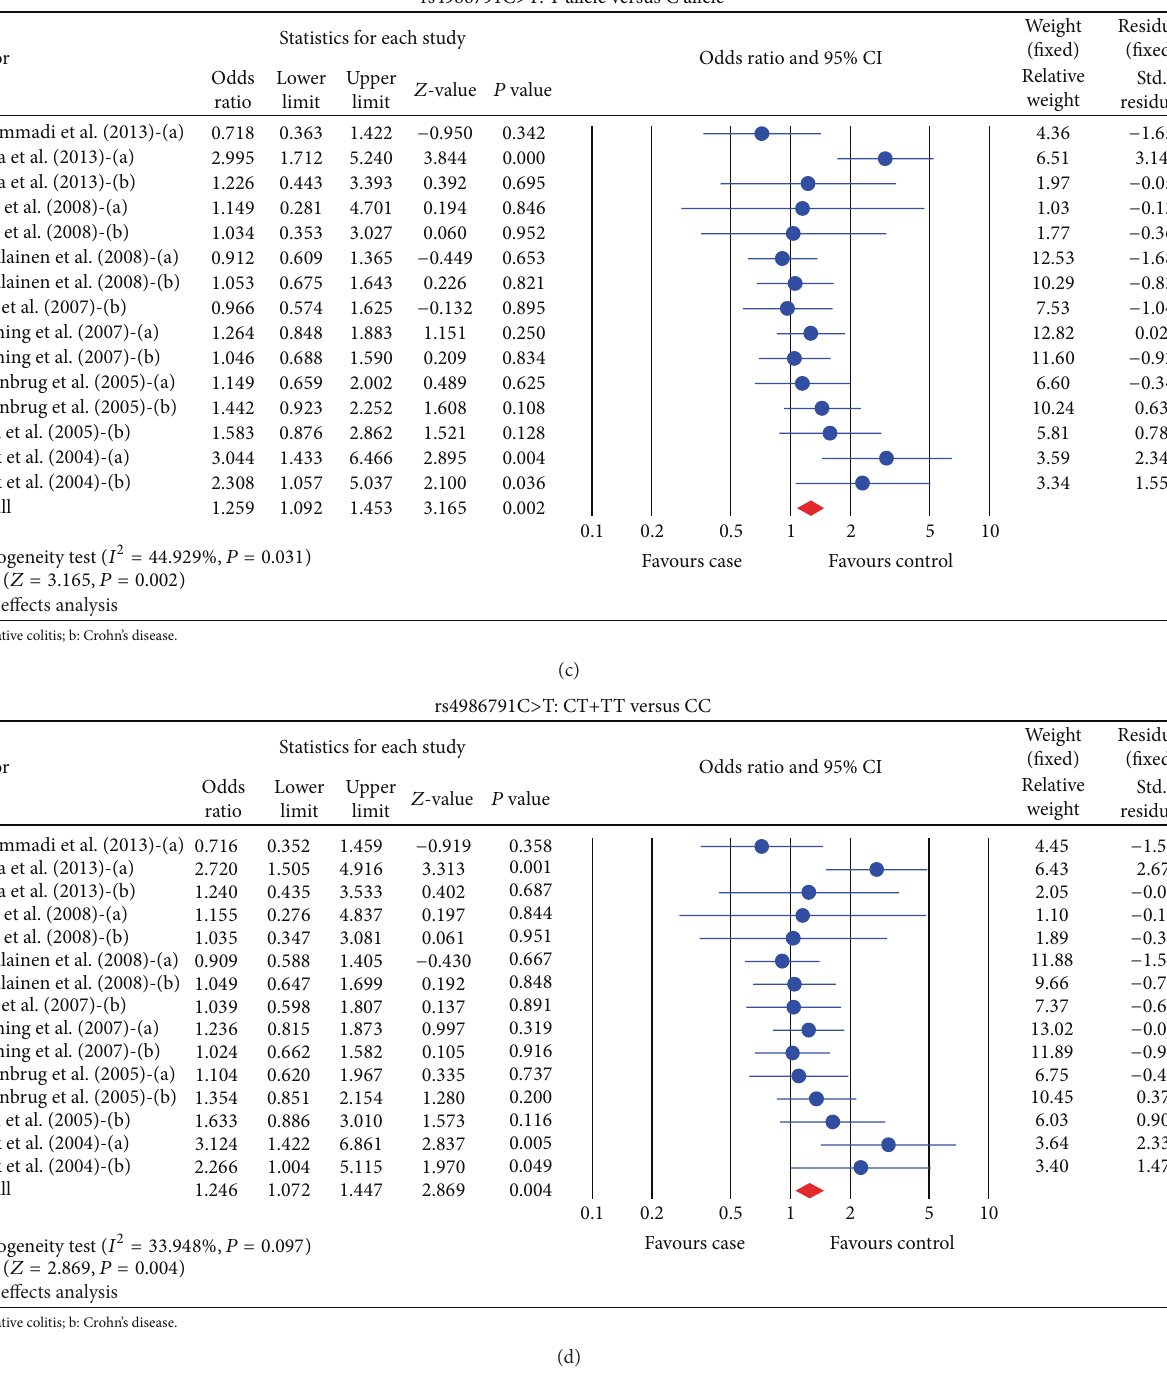
Figure 2: Forest analyses of the differences in allele and genotype frequencies of TLR4 rs4986790A > G and rs4986791C > T polymorphism between case and control groups. (a) Forest analyses of the differences in allele frequencies of rs4986790A > G. (b) Forest analyses of the differences in genotype frequencies of rs4986790A > G. (c) Forest analyses of the differences in allele frequencies of rs4986791C > T. (d) Forest analyses of the differences in genotype frequencies of rs4986791C >